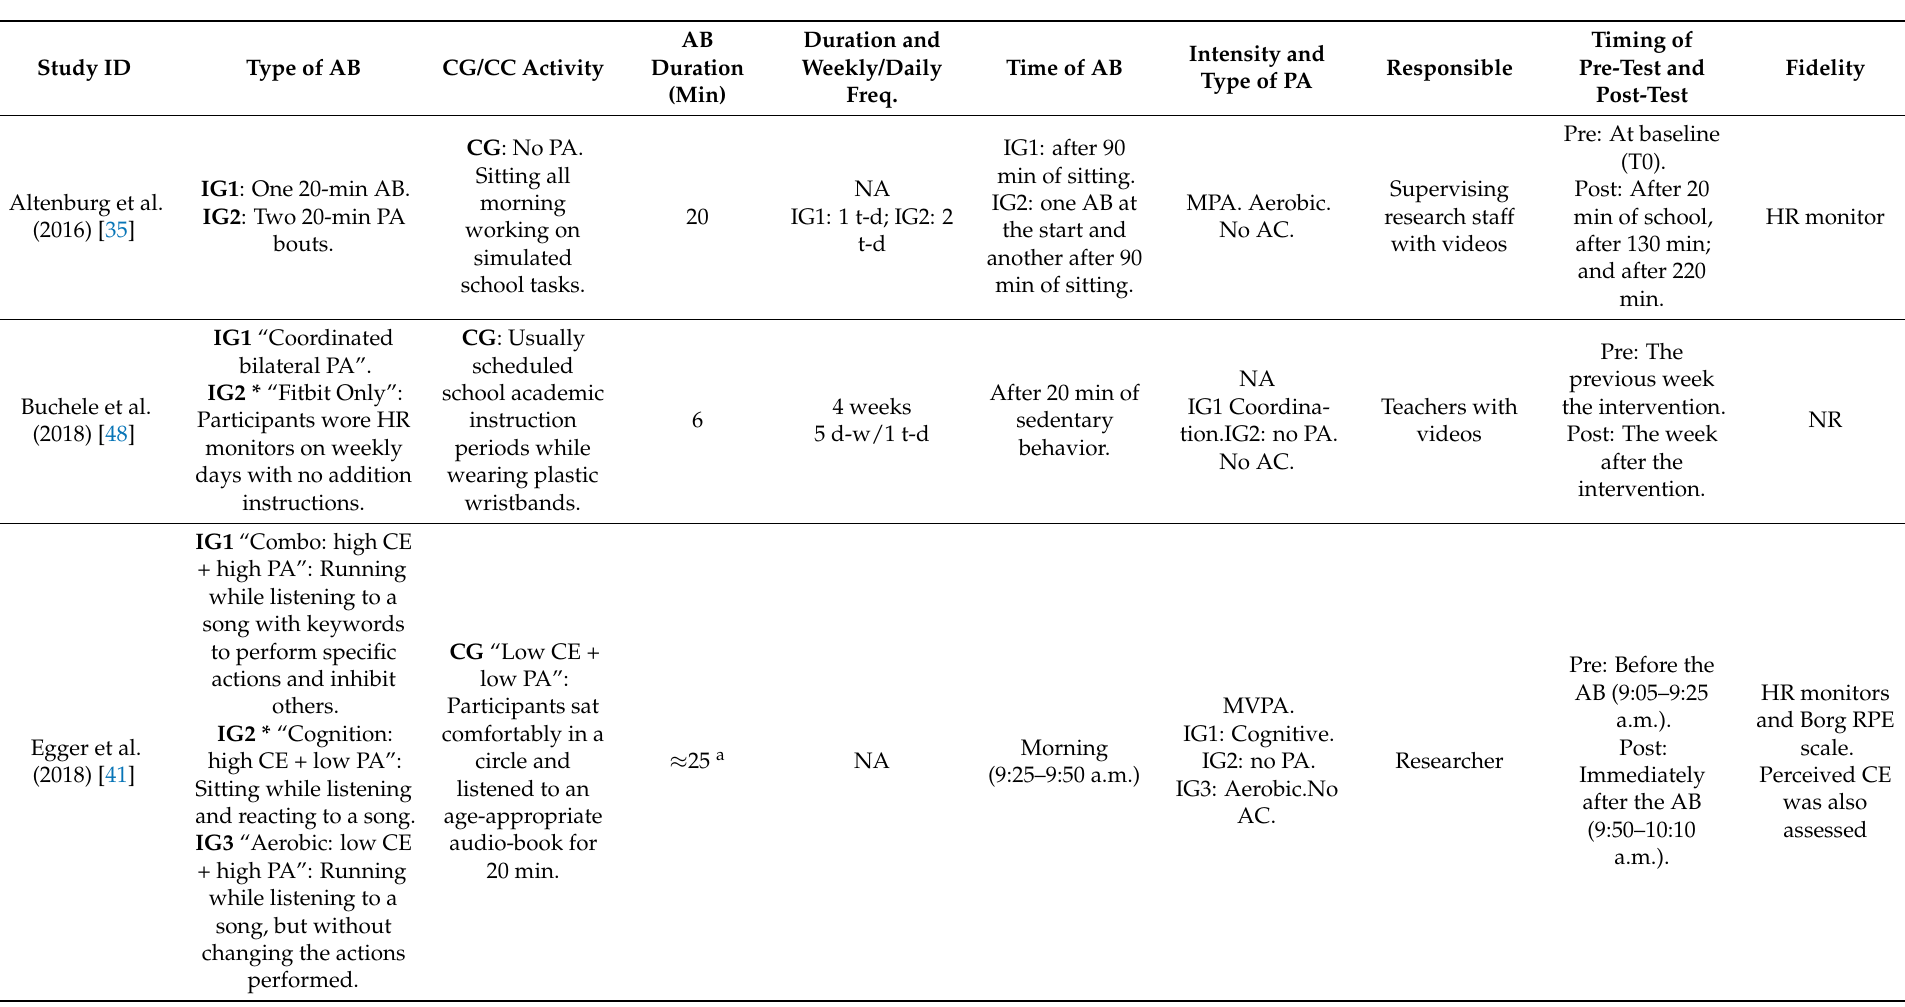
Table 4. Protocols of